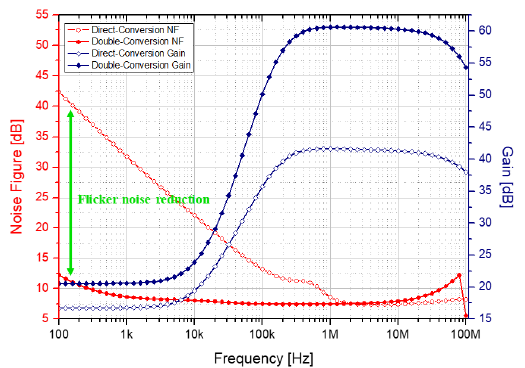
Figure 25. Noise simulation result for comparison.